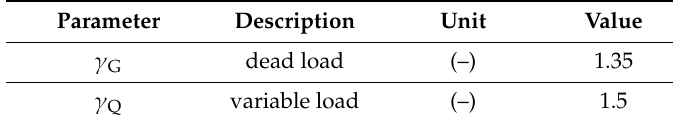
Table 3. Overview of the safety elements for the impact side.